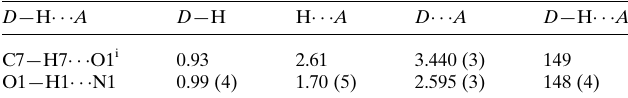
Table 1 Hydrogen-bond geometry (A˚ , (cid:2) ).